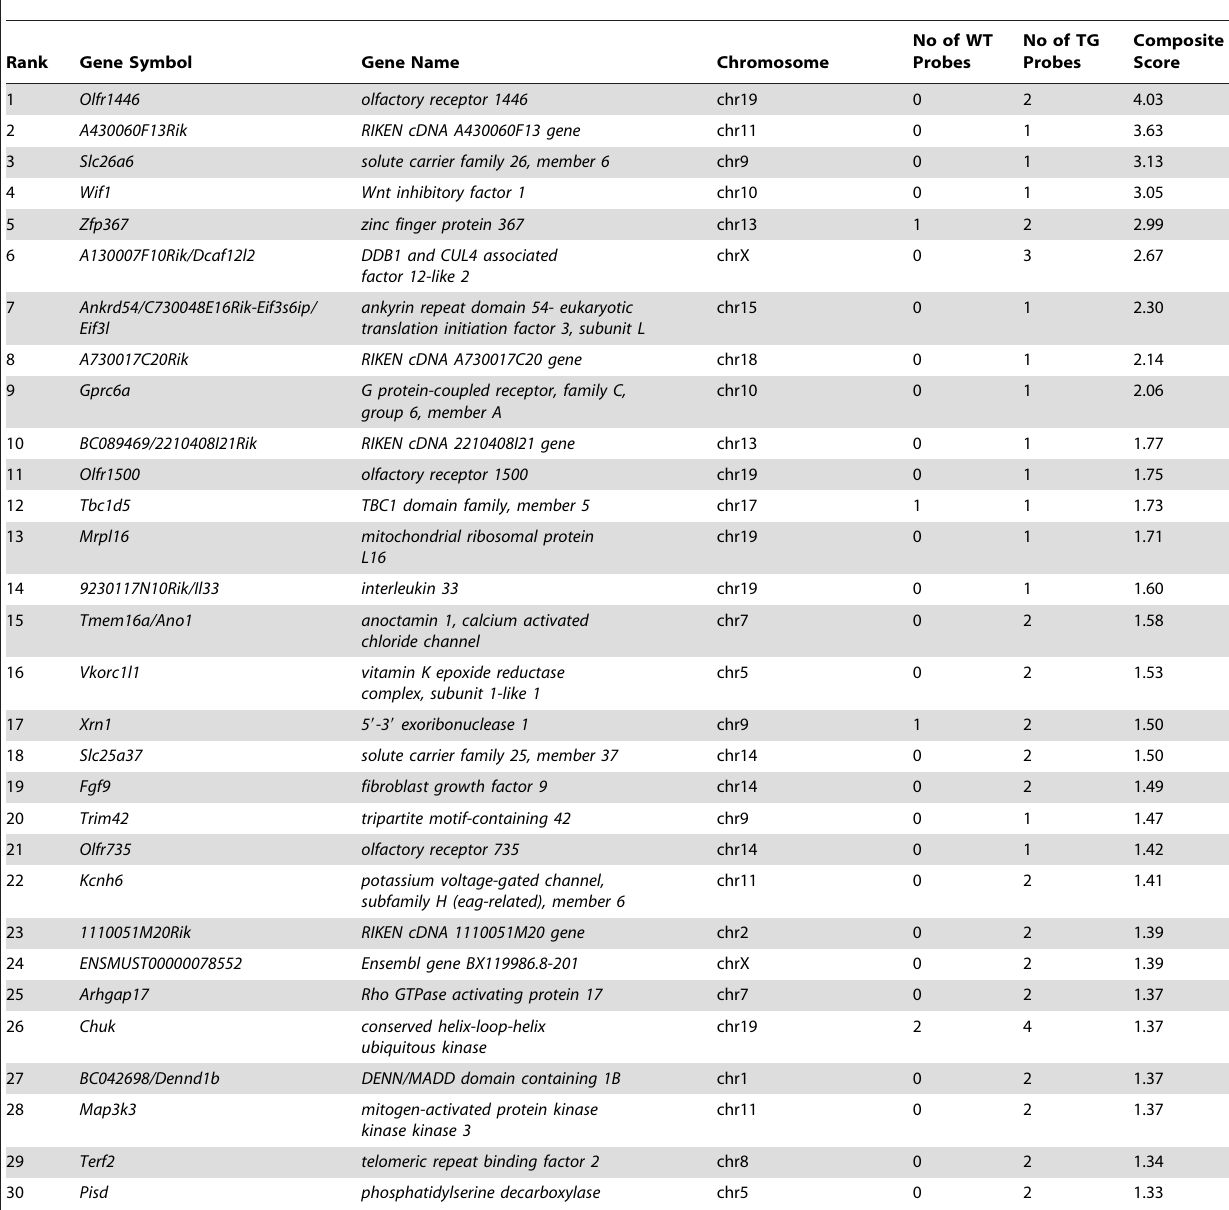
Table 2. The top genes with increased histone H3 acetylation in TG